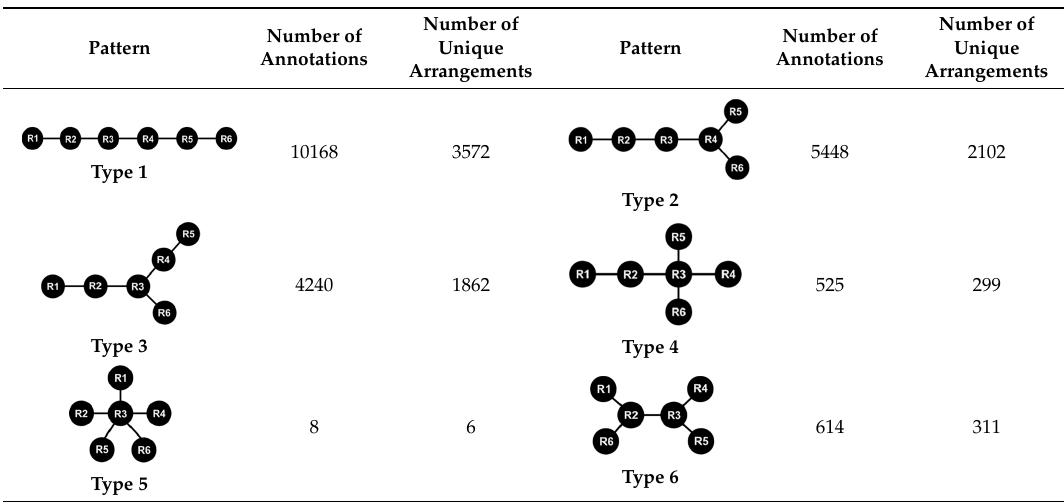
Table 1. Graph representations of six possible base connectivity patterns of a sextuple, where a base is connected to at least one other base by at least one hydrogen bond, and the number of occurrences found in the search dataset for each base sextuple type.